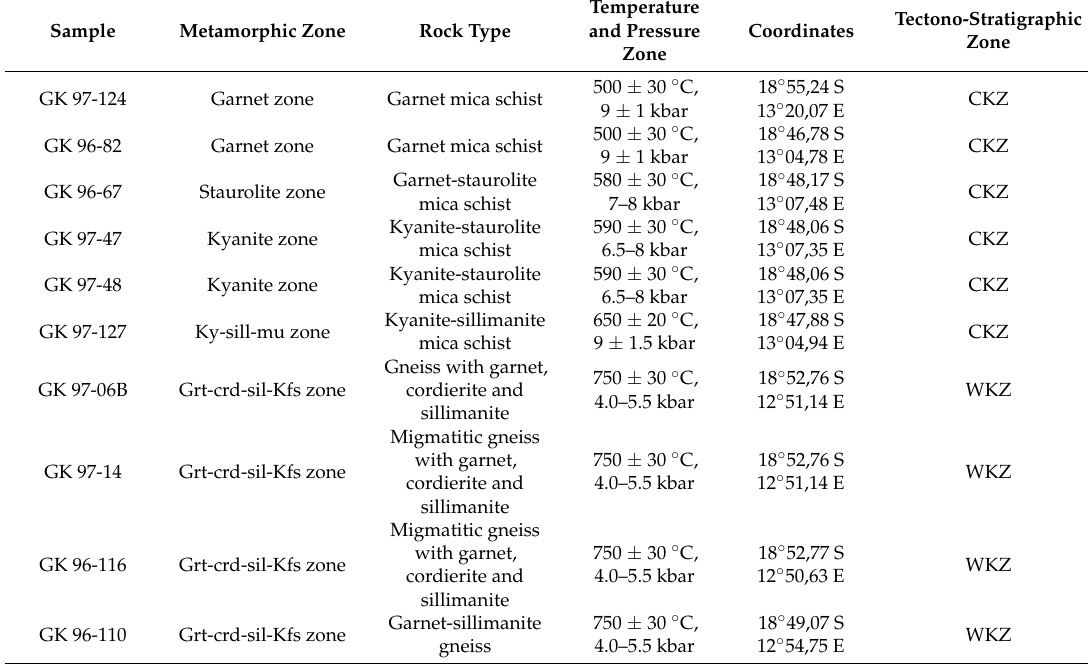
Table 1. Analyzed samples with the respective metamorphic rock type and P-T conditions (data from